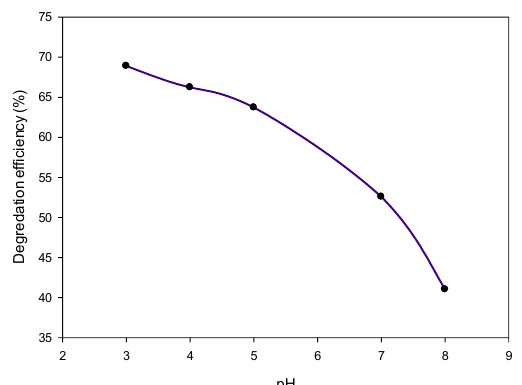
Fig. 5. The effect of solution pH on the Go-Pd NPs sonocatalytic degradation of IBF.